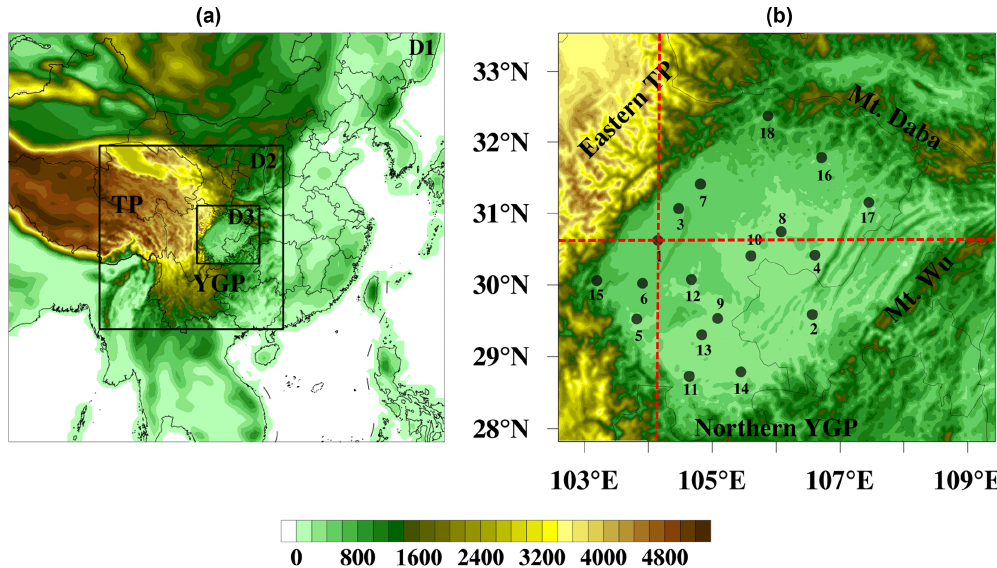
Figure 1. (a) Three nesting domains D1, D2, and D3 of the WRF-Chem simulation with the terrain heights (m in a.s.l.) and (b) the location of 18 urban observation sites (black dots; Table 1) including site 1 (Chengdu) with the intensive sounding observations and site 15 (Ya’an) with the ground-based MPL detection in the SCB with the surrounding Tibetan Plateau (TP), Yunnan-Guizhou Plateau (YGP), Mountains Daba (Mt. Daba), and Wu (Mt. Wu) in Southwest China. The red dashed lines indicate the location of the cross sections, respectively, along 30.67 ◦ N and 104.02 ◦ E. Table 1. Names of 18 observation sites with the corresponding site number (Fig. 1b) in the